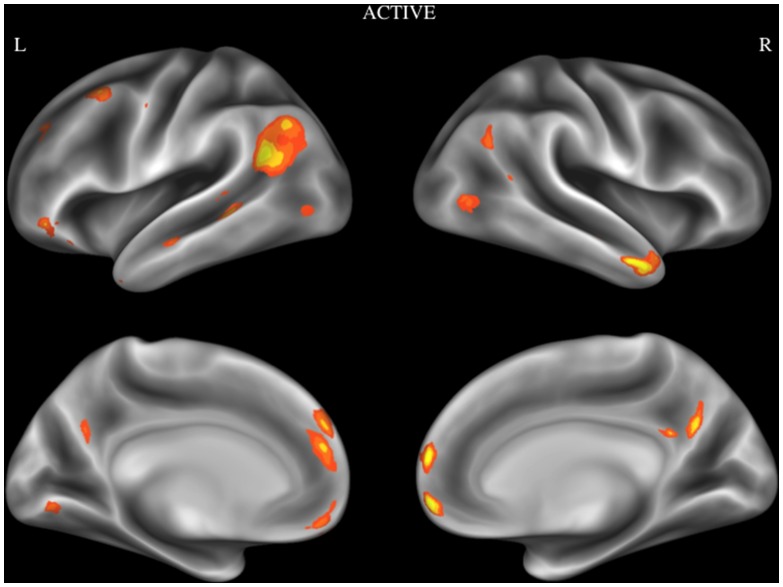
Activation likelihood estimation map showing significant convergent activity for studies in the active category.Surface maps of the activation likelihood clusters (false discovery rate P<.05) are shown on an inflated surface map in Caret [60].